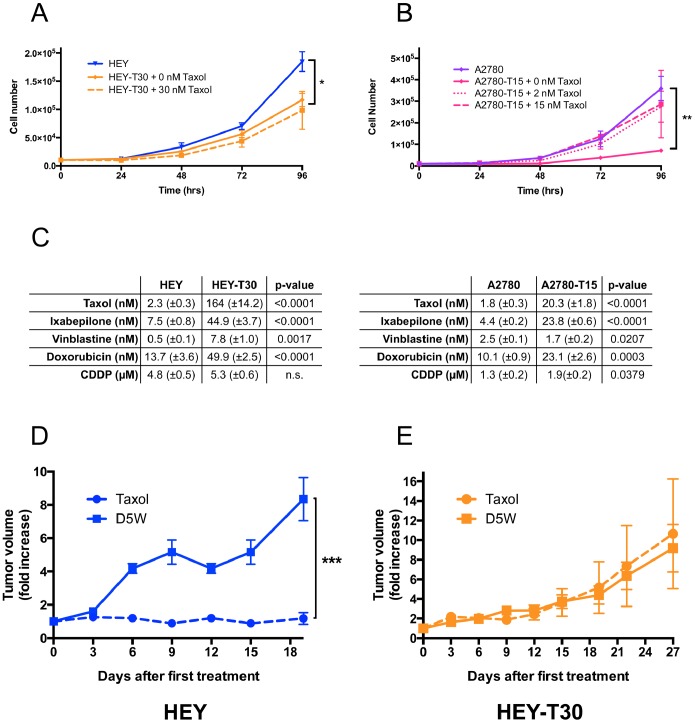
Characterization of the drug resistance phenotype.Proliferation kinetics of cell lines. Cells were grown in complete media with the indicated concentration of Taxol in 6-well dishes, and cells from duplicate wells counted every 24 hours. (A) HEY-T30 cells in the presence or absence of 30 nM Taxol proliferate more slowly than HEY cells (p<0.05, Repeated Measures Two-way ANOVA, Bonferroni posttest). (B) A2780-T15 in the presence of 2 nM and 15 nM Taxol grow similarly to A2780. However, in the absence of Taxol, A2780-T15 proliferates more slowly, suggesting Taxol dependence (p<0.01, Two-way ANOVA, Bonferroni posttest). Each growth curve represents the mean of at least two independent experiments each done in duplicates, each point is represented as the mean±SEM. (C) IC50’s of chemotherapeutic drugs in sensitive and resistant cell lines. In 96-well plates, cells were treated with serial dilutions of the indicated drugs and the concentration of 50% proliferation inhibition (IC50) determined using the SRB cytotoxicity assay. HEY-T30 are cross-resistant to ixabepilone and to vinblastine. There is modest cross-resistance to doxorubicin but not to CDDP. A2780-T15 are cross-resistant to ixabepilone, and modestly cross-resistant to doxorubicin and CDDP, but more sensitive to vinblastine. Data are presented as the mean±SEM of at least three independent experiments performed with six replicates. P-values calculated by unpaired t-test. (D, E) Comparison of HEY-T30 and HEY xenograft response to Taxol. Following subcutaneous injection of HEY-T30 or HEY cells, mice were divided into treatment groups of 6 animals each. When the average xenograft volume reached 120 mm3, Taxol treatment was administered at the maximal tolerated dose (MTD) of 20 mg/kg intraperitoneally every three days for five treatments (treatment days: 0, 3, 6, 9, 12), resulting in a cumulative dose of 100 mg/kg. Control animals received intraperitoneal injections of the diluent (5% dextrose in water; D5W) according to the same schedule. Tumors were measured every three days, and mean tumor volumes±SEM for each group shown at each time point. HEY xenografts responded to Taxol treatment, which potently suppressed tumor growth (Fig. 2D; dashed blue line). HEY-T30 xenografts did not respond to Taxol treatment (Fig. 2E; dashed orange line) and grew at a similar rate as vehicle-treated HEY-T30 xenografts. HEY Taxol vs HEY D5W on day 19, p<0.001; unpaired t-test.